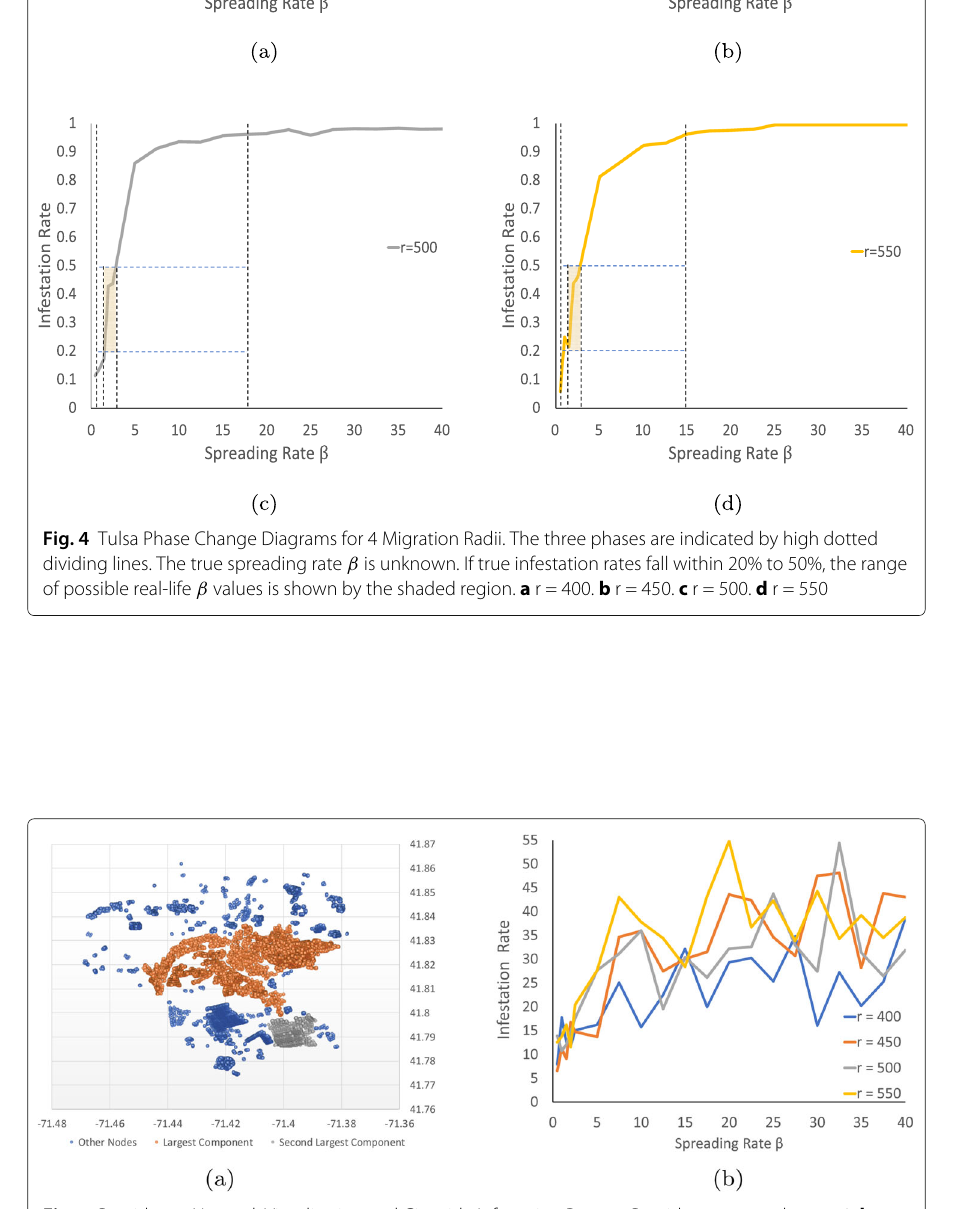
Fig. 5 Providence Network Visualization and Citywide Infestation Rates. a Providence network r = 450. b Infestation percentage for the entire city of Providence with varying migration radius